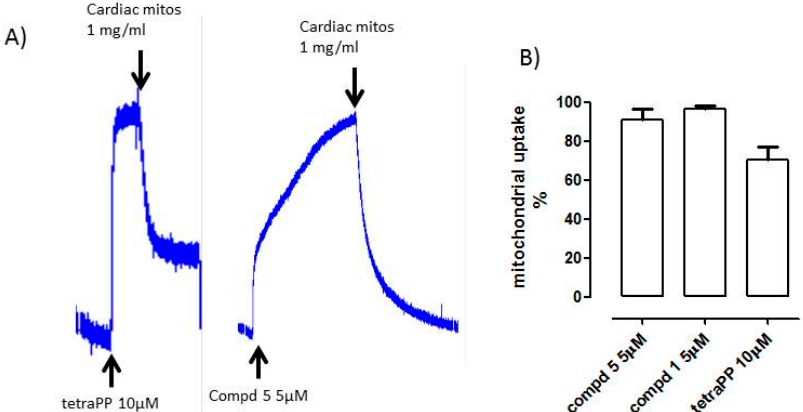
Figure 3. ( A ) Exemplificative tracing of mitochondrial uptake of tetraPP 10 microM and of the most potency triPP conjugated derivatives (compd 1 and 5 ); ( B ) Percentage of cardiac mitochondrial uptake of tetraPP and triPP-conjugated derivatives of isosteviol (cmpd 1 and 5).